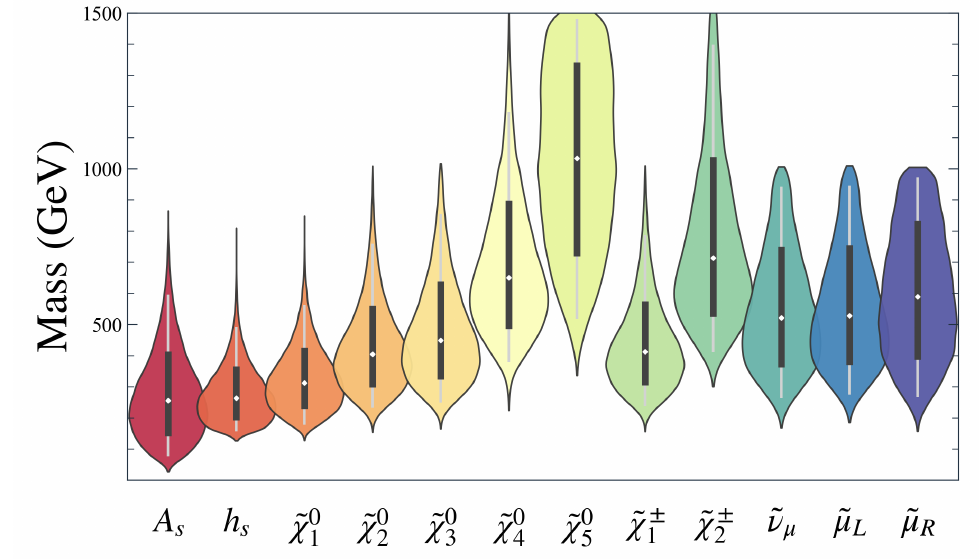
Figure 3 . Violin plots showing mass distributions of singlet Higgs, EWinos, and µ -type sparticles. Smuons are labeled by their dominated components. The violins are scaled by count. Thick vertical bar in center indicates interquartile range with white dot representing the median; long vertical line represents 95% confidence